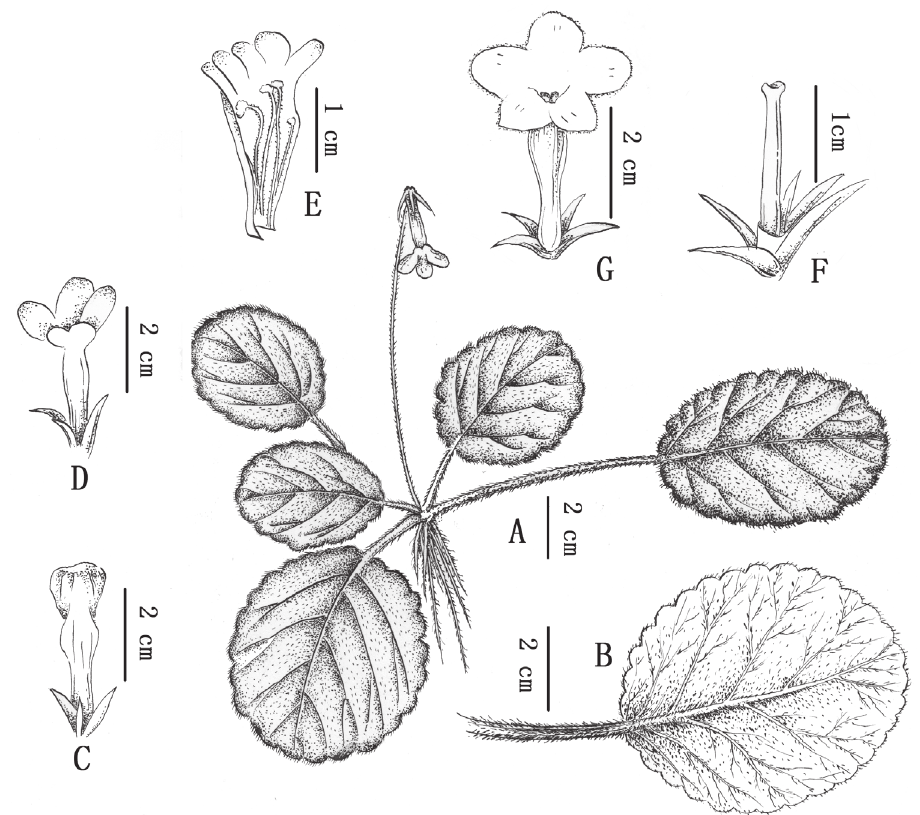
Figure 4. Oreocharis longituba W.H.Chen, Q.H.Nguyen & Y.M.Shui, sp. nov. (all drawings based on the holotype Y.M. Shui et al. B2013-551 in KUN, drawn by J.X. Liu). A Habit B Abaxial leaf surface C Opening flower from below showing the inflated part near the distal end of the corolla tube D Open flower from above E Opened corolla showing two pairs of stamens F Pistil (immature at male stage), disc and calyx G Front view of